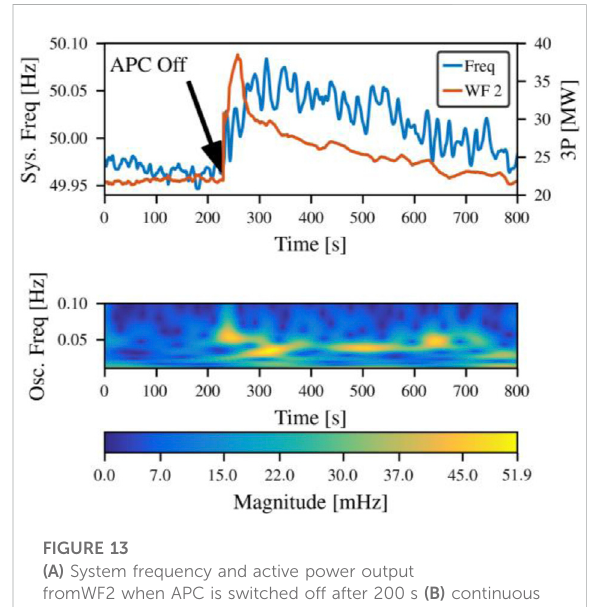
FIGURE 13 (A) System frequency and active power output fromWF2 when APC is switched off after 200 s (B) continuous wavelettransformshowingtheincreaseinoscillationmagnitudein system frequency for oscillation frequencies between 0.02 and 0.1 Hz.